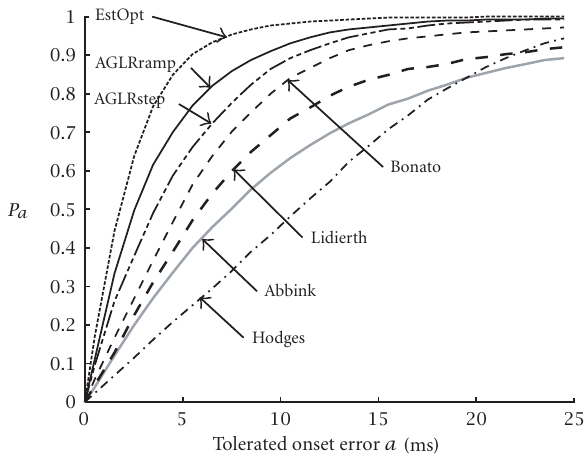
Figure 4: Accuracy functions of onset estimates ( Mixed Trials data set). The ordinate value denotes the probability that the tolerated error a given by the abscissa value is not exceeded. The further a curveisbenttotheupper-leftcorner,thebetteristheonsetdetection quality.